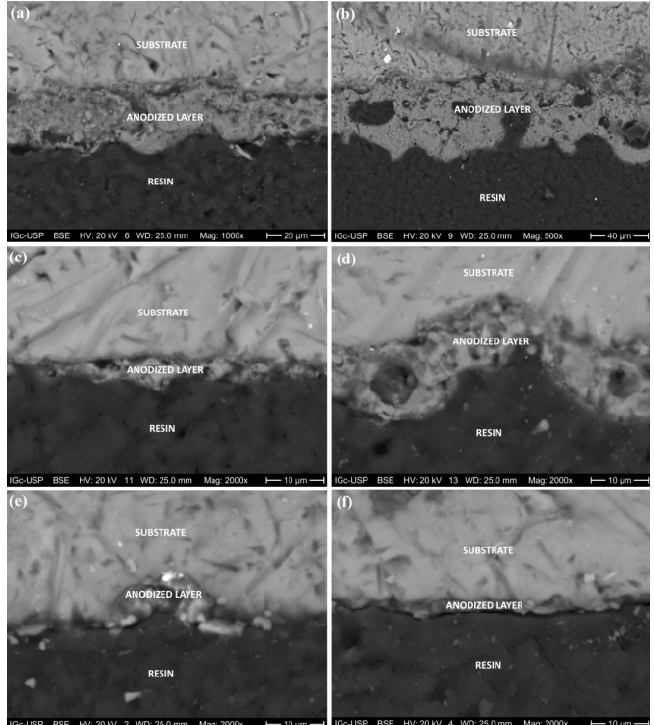
Figure 5. SEM micrographs (backscattered electrons mode) showing the cross-section morphologies of the anodized layers: a) SI-20; b) SI-30; c) PHO-20; d) PHO-30; e) BO-20; f)